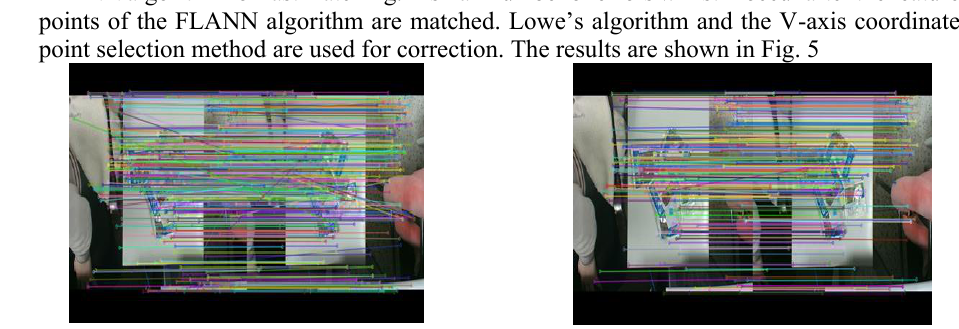
Fig. 5. Feature point